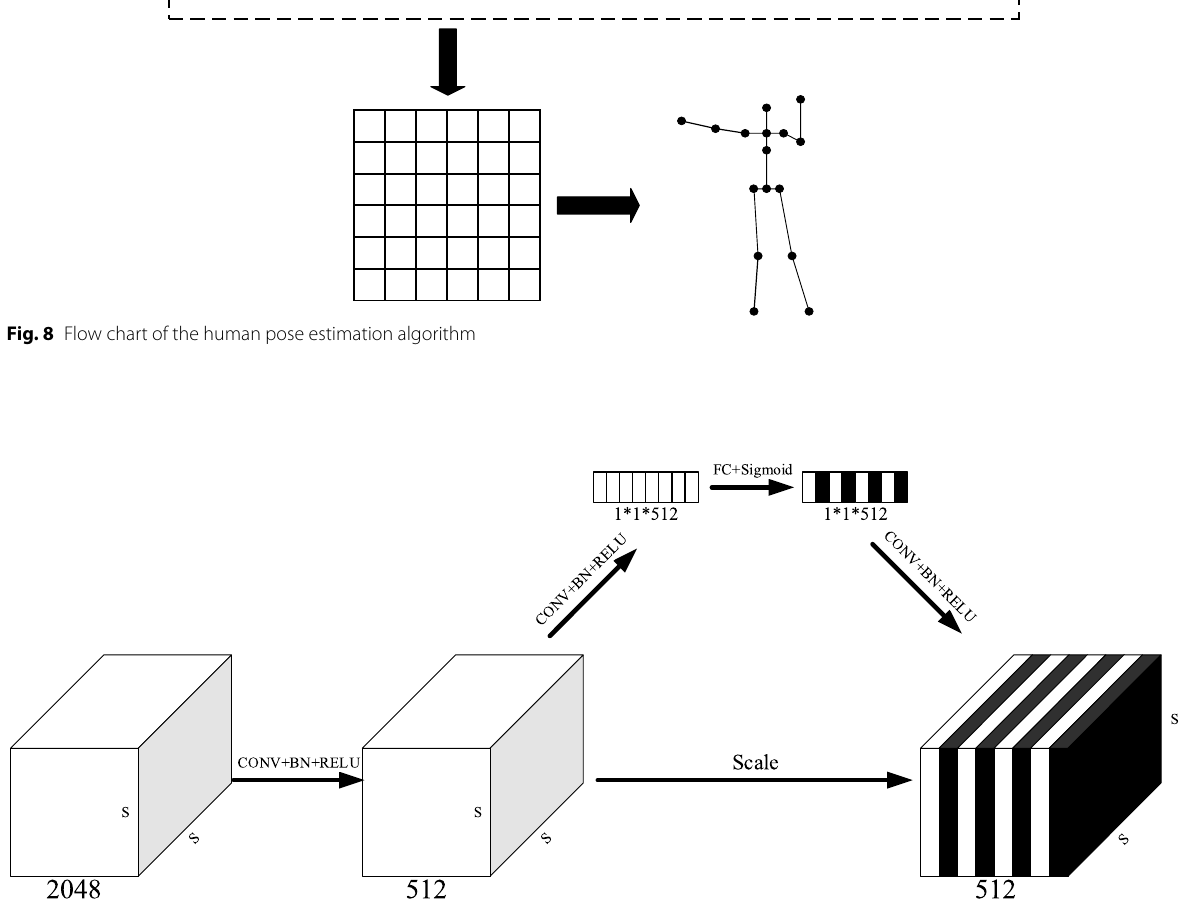
Fig. 8 Flow chart of the human pose estimation algorithm